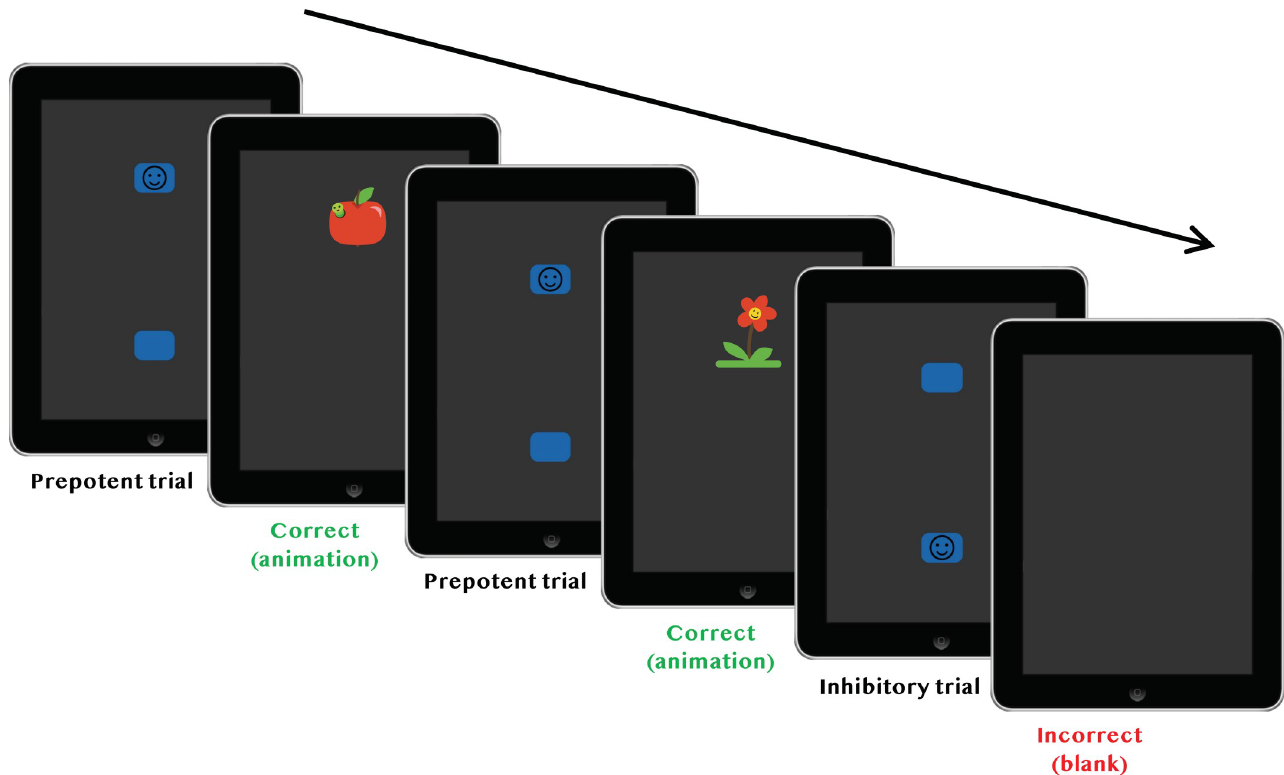
Fig 1. Illustration of the Early Childhood Inhibitory Touchscreen Task